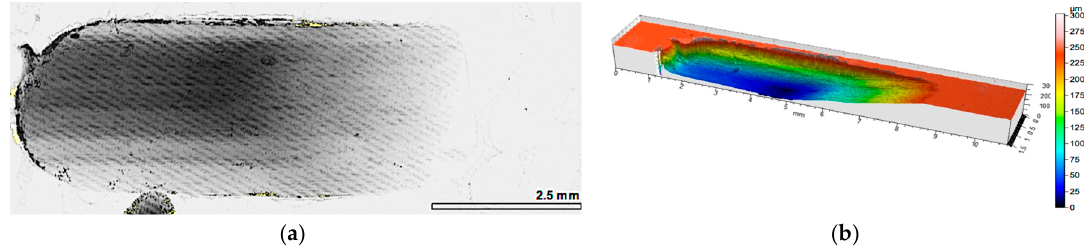
Figure 7. View of wear track in AlSi12/Al 2 O 3 _2 composite layer (P2) after dry sliding condition: ( a ) digital image; ( b ) cross-section through 3D view.